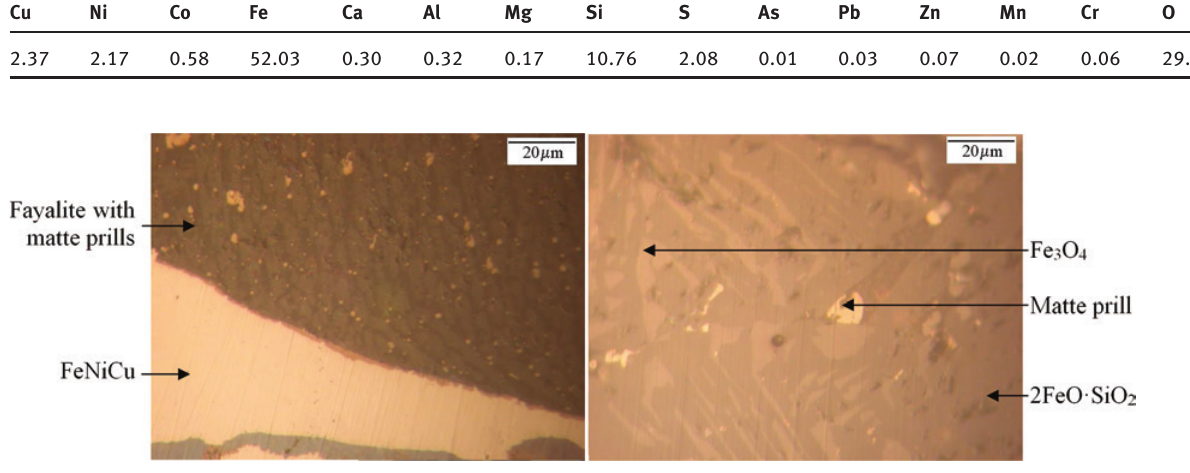
Fig. 2: Micrograph of the upper (a) and slag rich bottom part of the sample (b) after 5 wt% coke